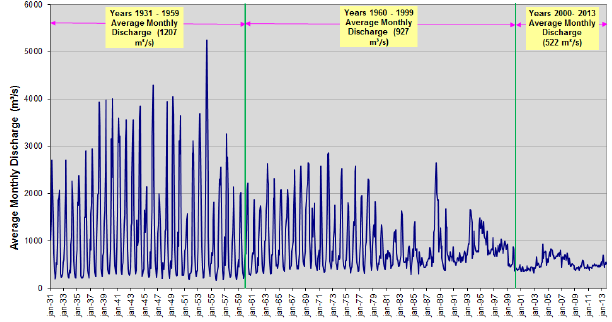
Figure 4. Mean monthly flow of the River Tigris at Baghdad for the period 1931-2010 [13].